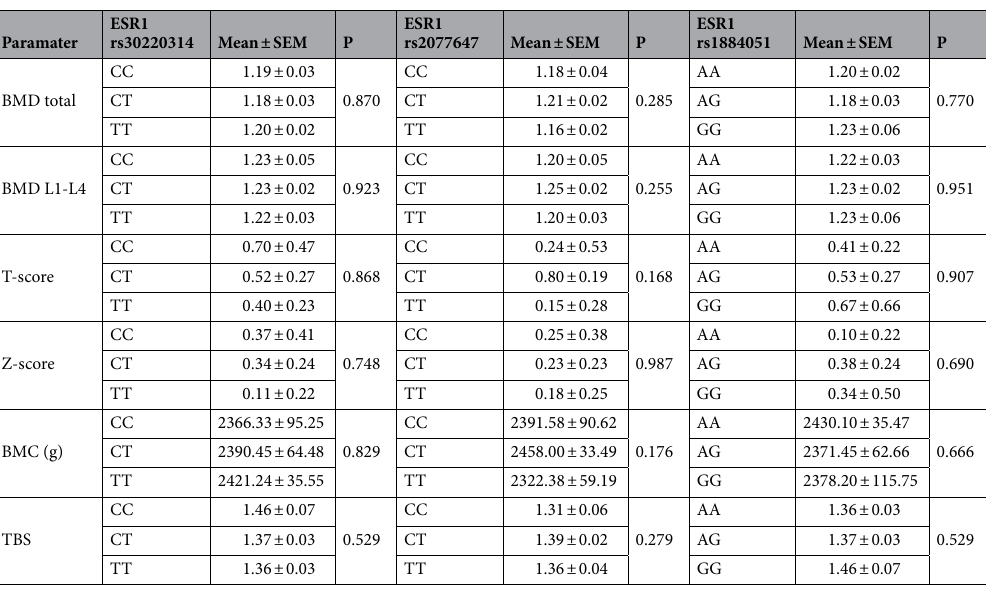
Table 6. Analysis of bone metabolism parameters in relation to ESR1 gene polymorphisms in patients with hyperandrogenism. BMC bone mineral content, TBS trabecular bone score, BMD L1-L4 bone mineral density L1-L4, T-score the ratio of the bone mineral density (BMD) of the test person to the average bone density of the young person, Z-score bone mineral density index, BMD total bone mineral density